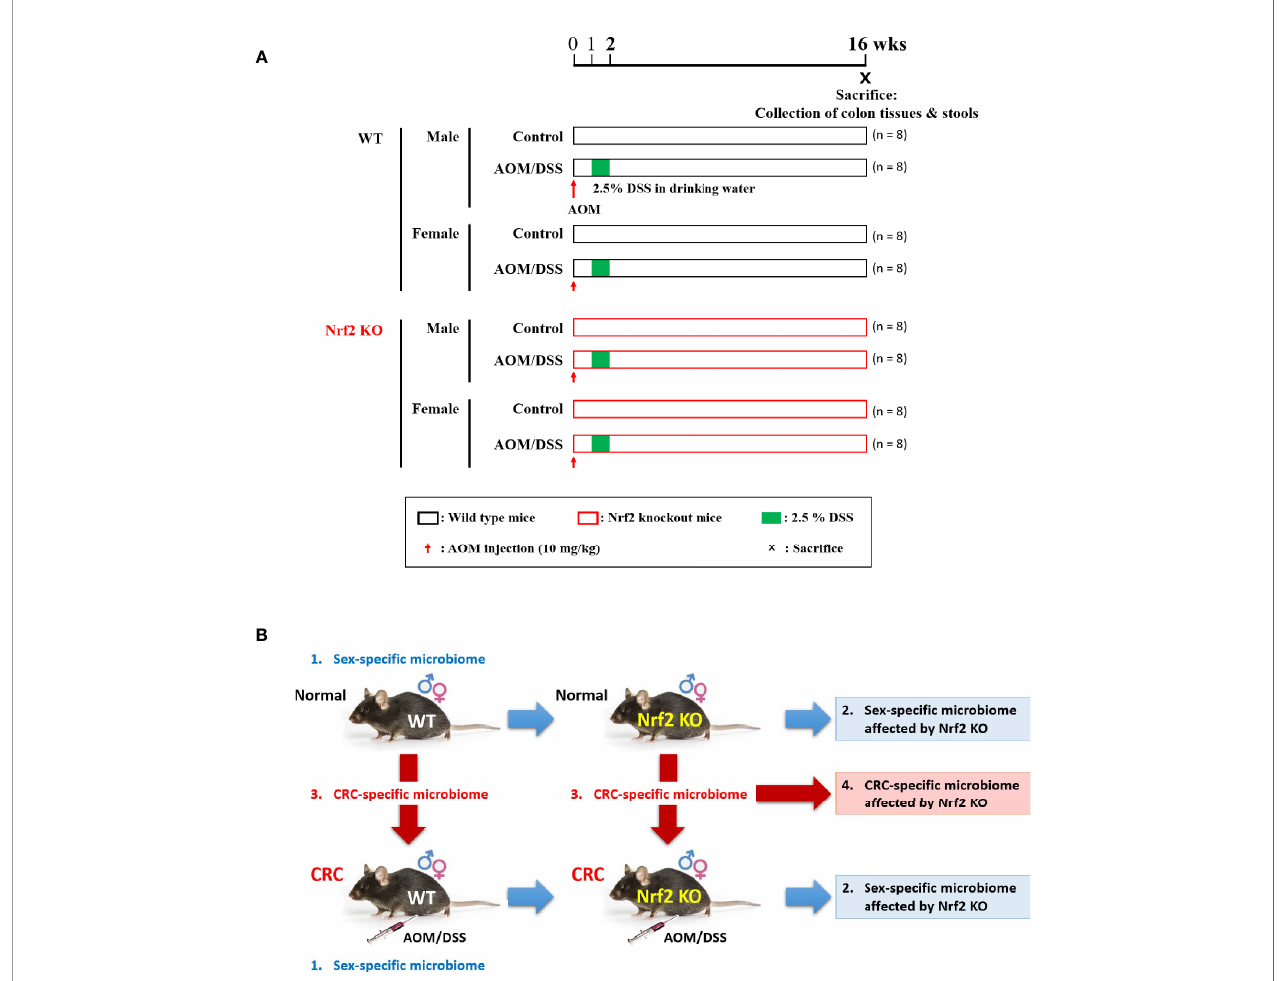
FIGURE 1 | Experimental scheme for evaluating the differential effects of Nrf2 KO on the gut microbial composition depending on sex and CRC induction. (A) Experimental design. Male and female WT and Nrf2 KO mice were treated with AOM/DSS to induce colitis-associated CRC. The mice were injected with AOM (10 mg/kg bodyweight) on Day 0. At week 1 post-AOM injection, DSS (2.5% w/v) was supplemented in the drinking water for one week. The fecal samples were collected and the mice were sacri fi ced at week 16 post-AOM injection (aged 24 weeks). (B) Data analysis scheme. Examination of sex-speci fi c changes in the gut microbiome composition by comparing the gut microbiota composition between males and females in the following groups: WT control, WT AOM/DSS-treated, Nrf2 KO control, and Nrf2 KO AOM/DSS-treated groups. Based on the results of this analysis, the effect of Nrf2 KO on the gut microbiome composition was examined. Furthermore, the CRC-speci fi c differences in the gut microbiome composition were analyzed by comparing the gut microbiota composition between control and AOM/DSS-treated animals in the following groups: male WT, female WT, male Nrf2 KO, and female Nrf2 KO groups. Based on this analysis, the effect of Nrf2 KO on the CRC-speci fi c changes in the gut microbiome composition was examined. CRC, colorectal cancer; WT, wild-type; KO, knockout; Nrf2, nuclear factor-erythroid 2- related factor 2; AOM, azoxymethane; DSS, dextran sodium sulfate; ♂ , male; ♀ ,